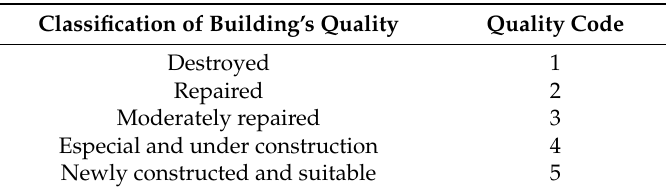
Table 6. Rating the quality of